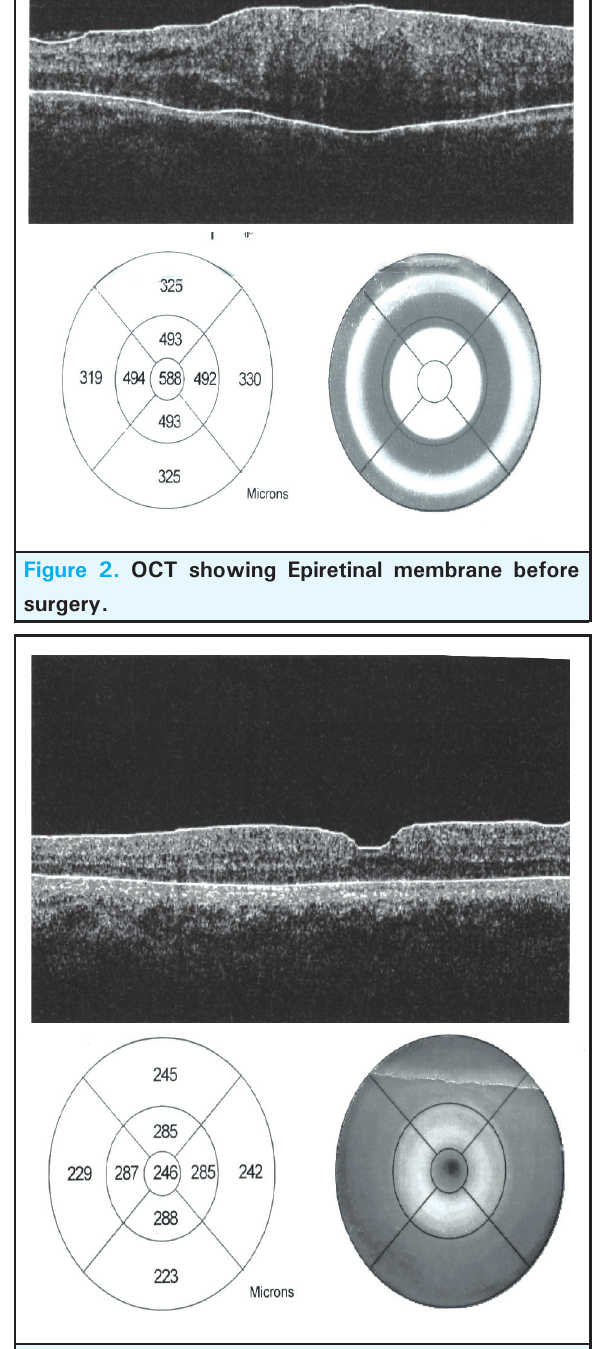
Figure 3. OCT showing macular thickness following vitrectomy and membrane